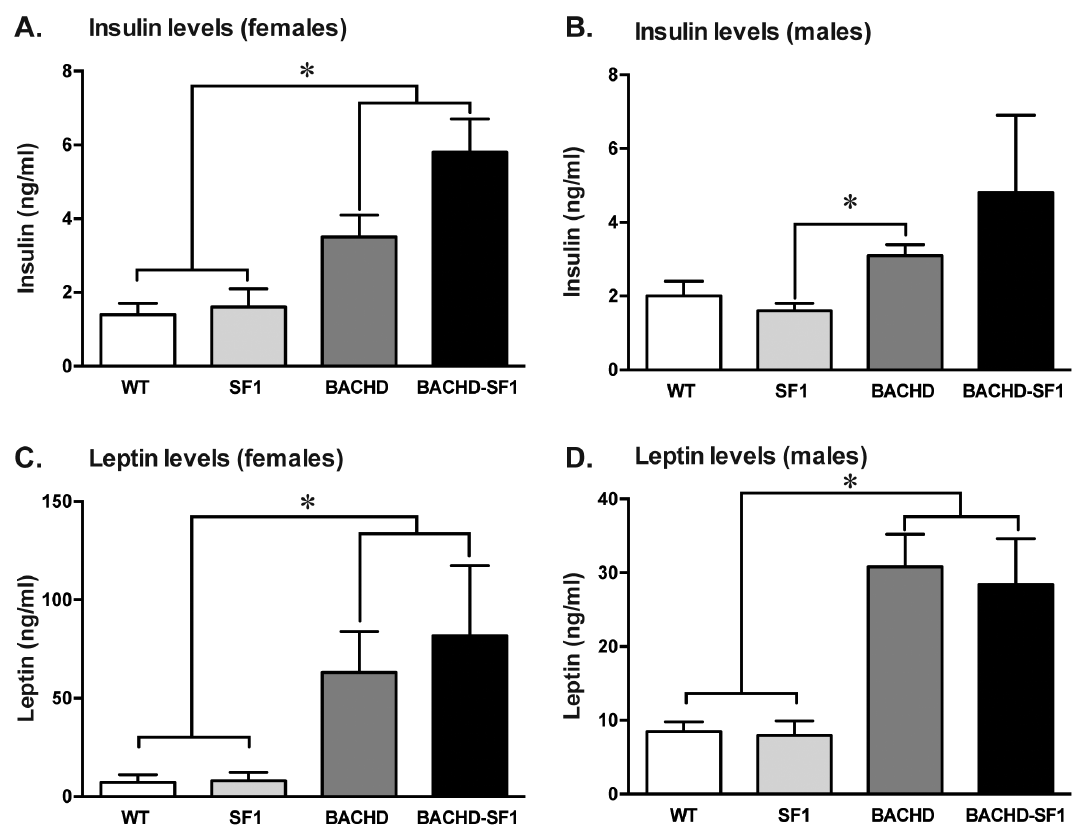
Figure 3. Alterations in serum insulin and leptin levels. A, B. Circulating insulin concentration was measured in blood samples from all genotypes at 4 months of age by ELISA. Serum insulin levels were significantly higher in BACHD and BACHD-SF1 females compared WT and SF1 controls while in males, only the BACHD group had significantly enhanced insulin concentration compared to SF1 controls. C, D. Serum leptin concentration as measured by ELISA was significantly higher in BACHD and BACHD-SF1 mice compared to WT and SF1 controls in both males and females. Data presented as mean 6 SEM (A–B, * p , 0.05, Kruskal-Wallis non-parametric ANOVA with Dunn’s multiple comparisons post-hoc test, C–D, * p , 0.05, one-way ANOVA with Tukey multiple comparisons post-hoc test), n=11–28/genotype/sex in each group. Detailed statistical analyses are outlined in Figure 3 of Statistical Results S1.